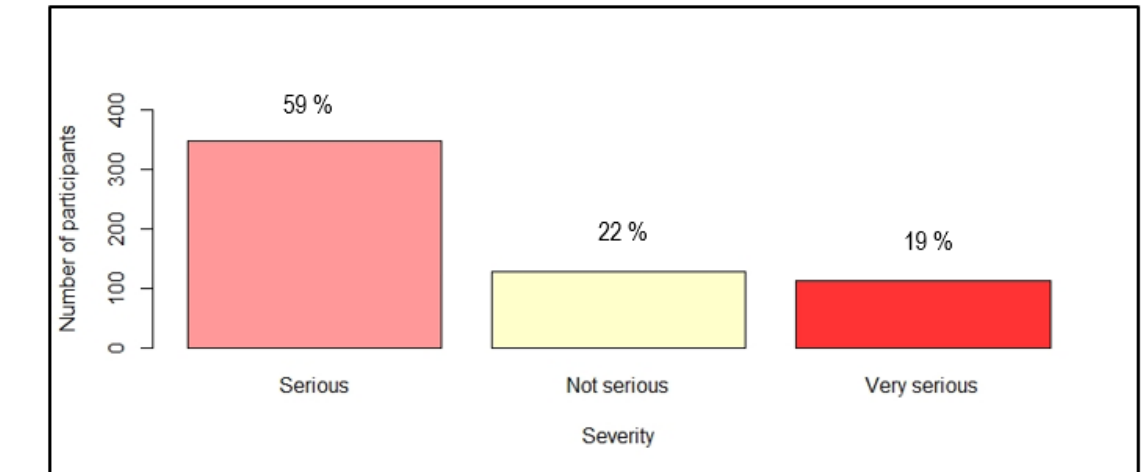
Figure 2. Distribution of participants according to their perception of severity of dengue ( n = 587).